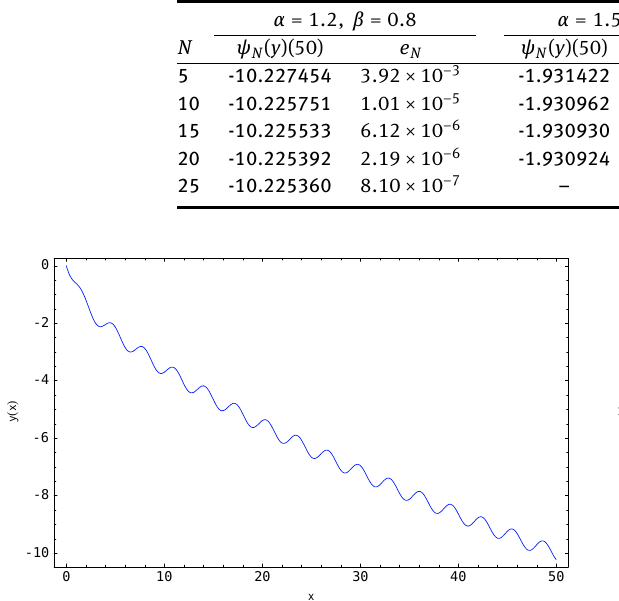
Fig. 10: Computational results of y ( x ) with h = 1 , N = 20 for α = 1.2, β = 0.8 for Example 5.